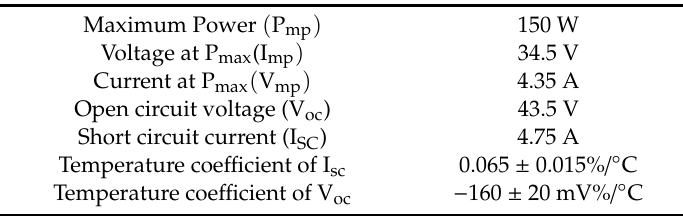
Table 1. Electrical characteristics of the BP SX 150S PV module.